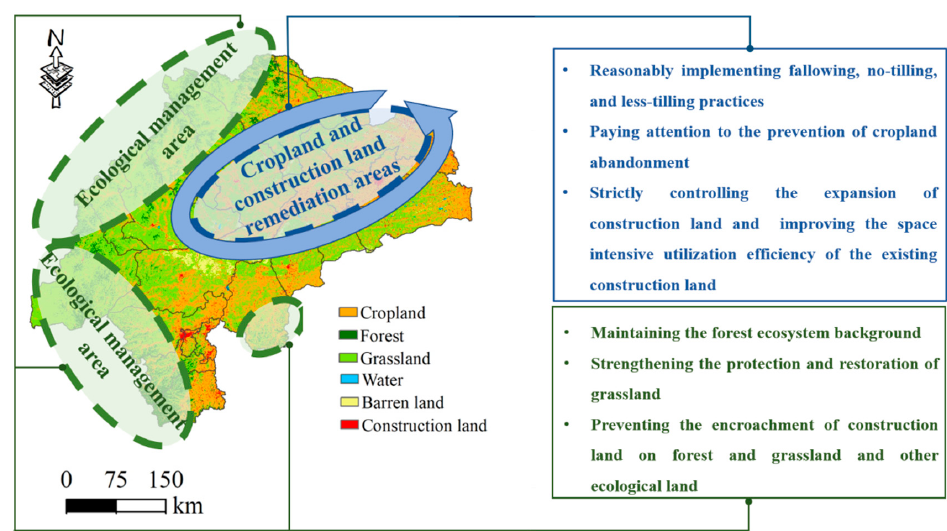
Figure 9. Zoning management measures for land use optimization and management in the study area.